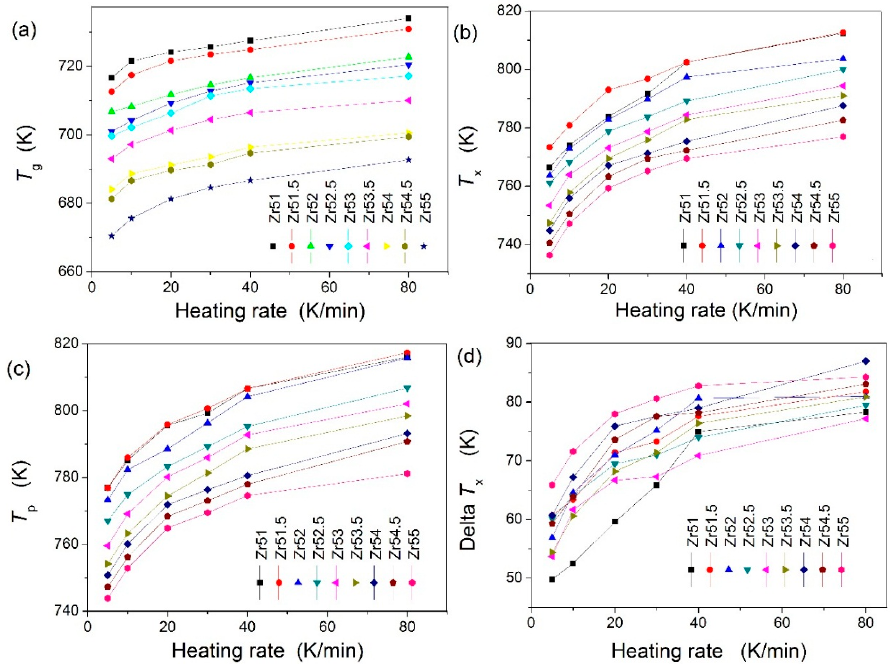
Figure 3. Dependences of the characteristic temperatures on the heating rates: ( a ) T g ; ( b ) T x ; ( c ) T p ; and ( d ) Δ T x .